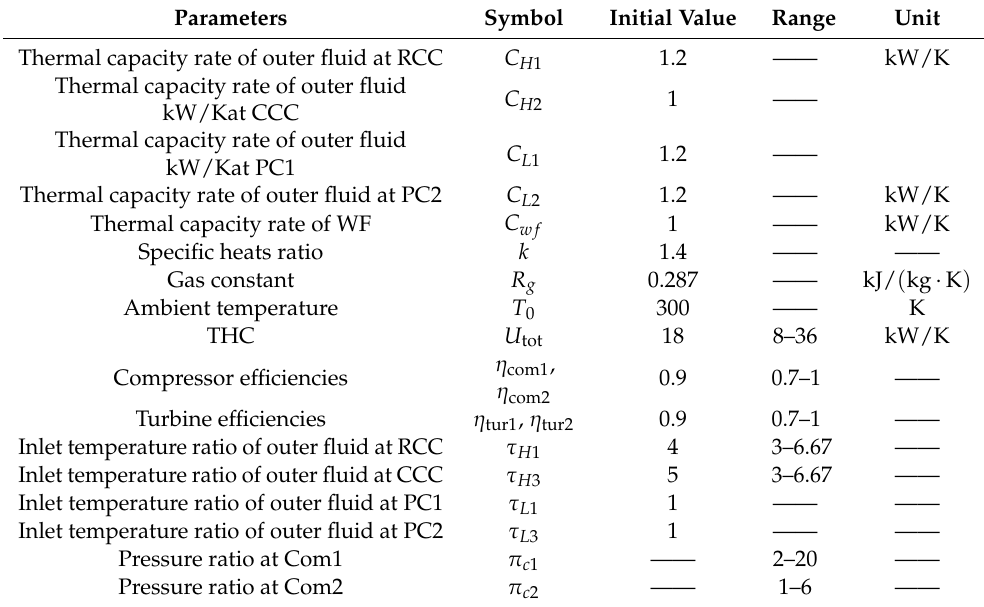
Table 1. Values or ranges of the